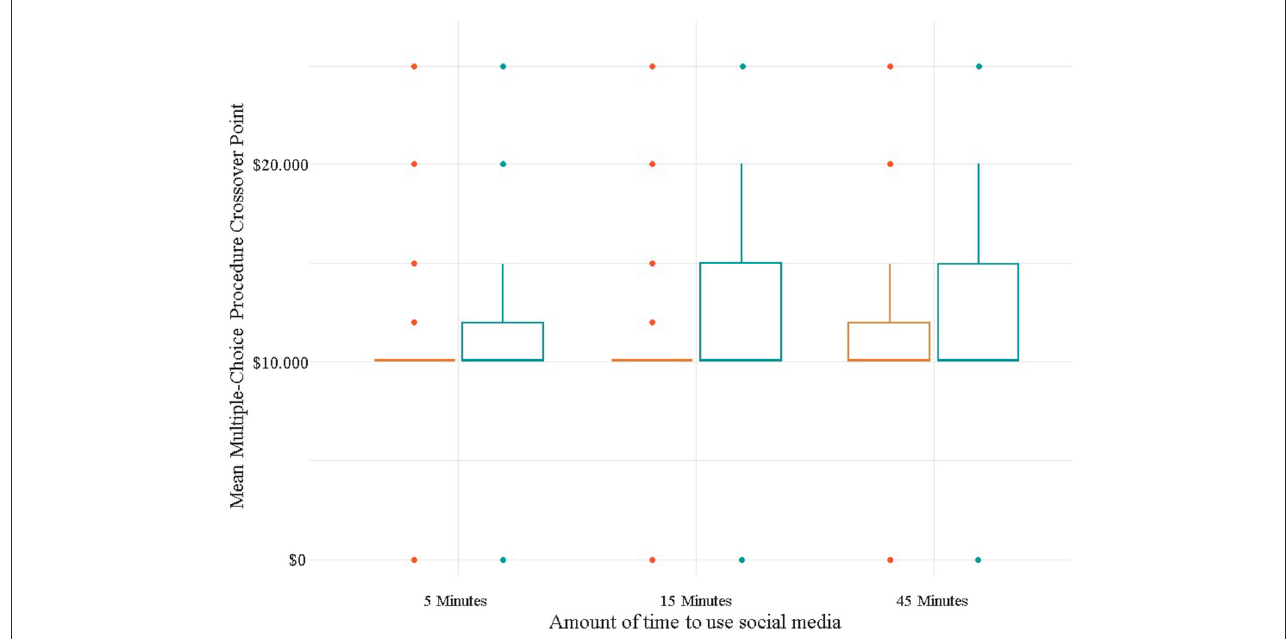
FIGURE2 Differences in the average crossover points according to the magnitude of the reinforcer.